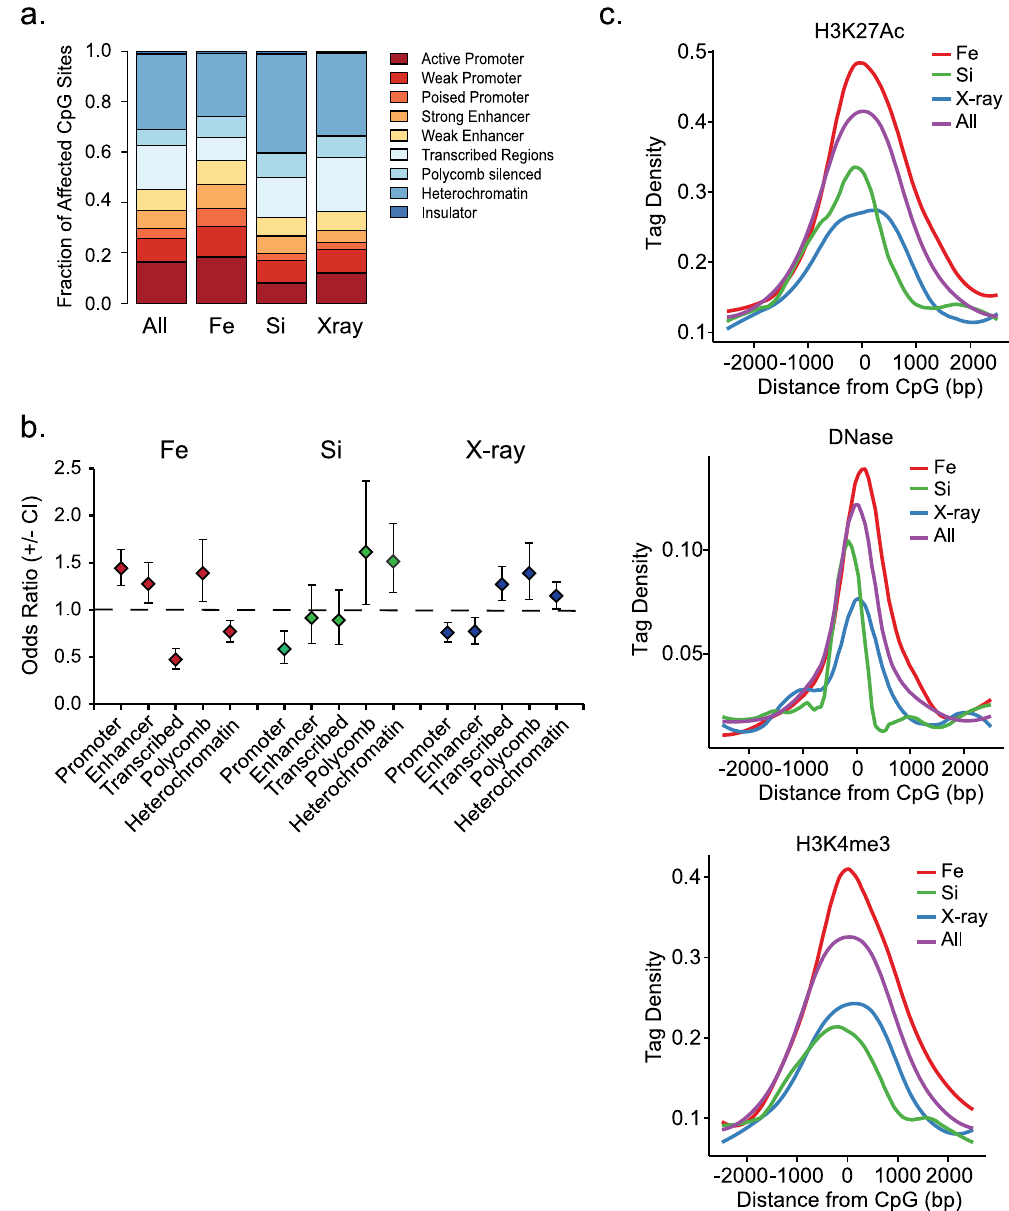
Figure 5. HZE-particles of distinct LETs affect methylation of CpG sites in different genomic chromatin compartments. CpG sites were annotated to a chromatin-based functional genomics annotation, ChromHMM, established by Ernst et al . 42 using 14 different chromatin features from ENCODE data from human epithelial cells (HMEC). Shown is the fraction ( a ) and relative enrichment ( b ) of 56 Fe, 28 Si or X ray affected CpG sites that overlap in the indicated compartment, relative to that of ‘All’ CpG sites on the array. Data represent the odds ratios determined by Fishers exact + / − the 95 th confidence interval. ( c ) Normalized average tag densities of H3K27 acetylation ChIP-seq ( Top ), DNaseI-seq ( Middle ) or H3K4me3 ChIP-seq ( Bottom ) surrounding all assayed CpGs (All), or the subset of CpGs whose change in methylation was significantly associated with 56 Fe, 28 Si or X ray dose. Data are derived from ENCODE CHIP-seq and DNAse-I seq data from A549 lung cancer cells 76 . Note the over-representation of H3K4me3, H3K27ac, and DNaseI accessibility at 56 Fe-affected